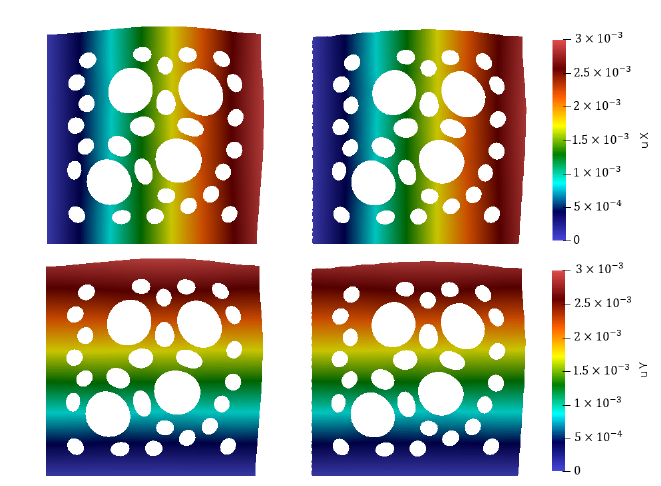
Figure 11. Elasticity problem. Case 1 (homogeneous boundary conditions). First row: displacement X-component. Second row: displacement Y-component. Left: Reference solution ( DOF h = 170,460). Right: Multiscale solution with 24 multiscale basis functions, e L 2 = 2.117 ( M g = M = 24, M p = 0, DOF H = 4900).